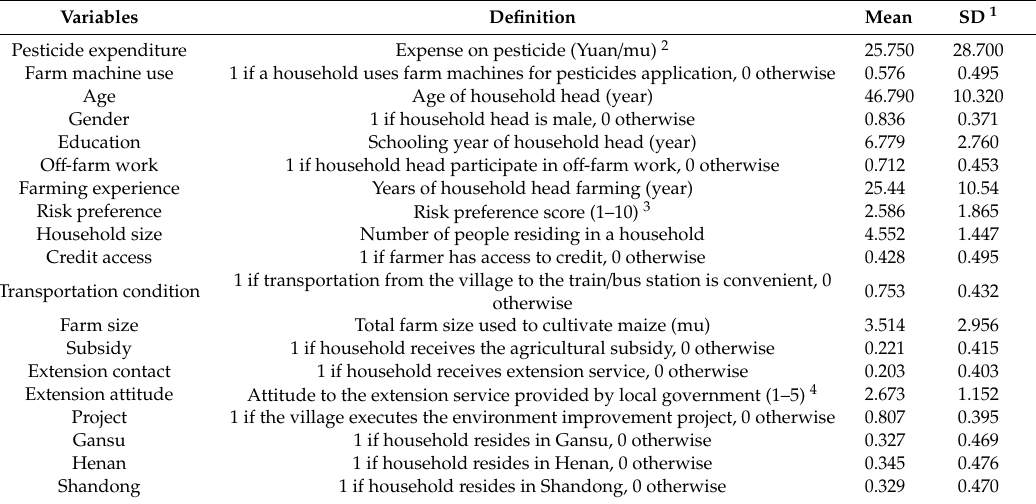
Table 1. Definition and summary statistics of the selected variables.